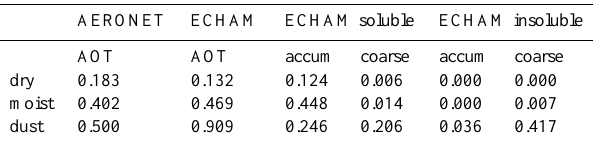
Table 1. Observed and simulated AOT and simulated contributions from relevant modes in the dry, moist and dust